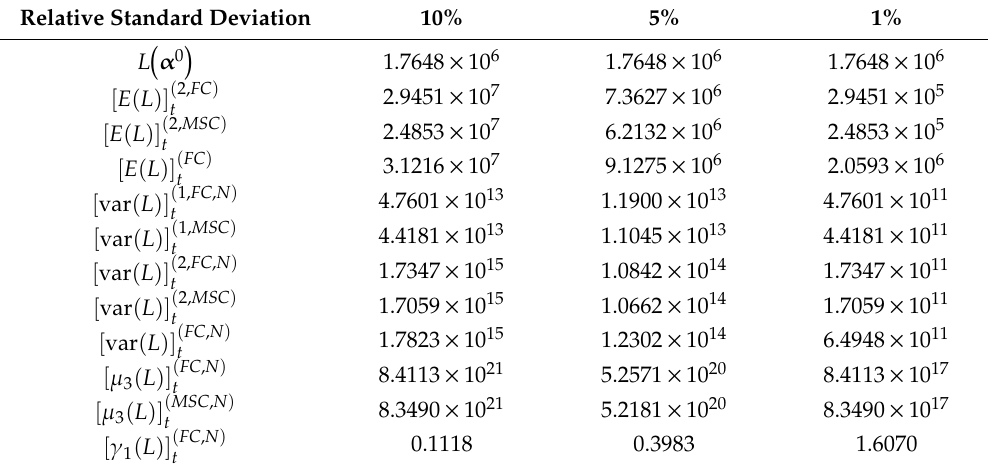
Table 26. Response moments for various relative standard deviations of total microscopic cross section which are fully